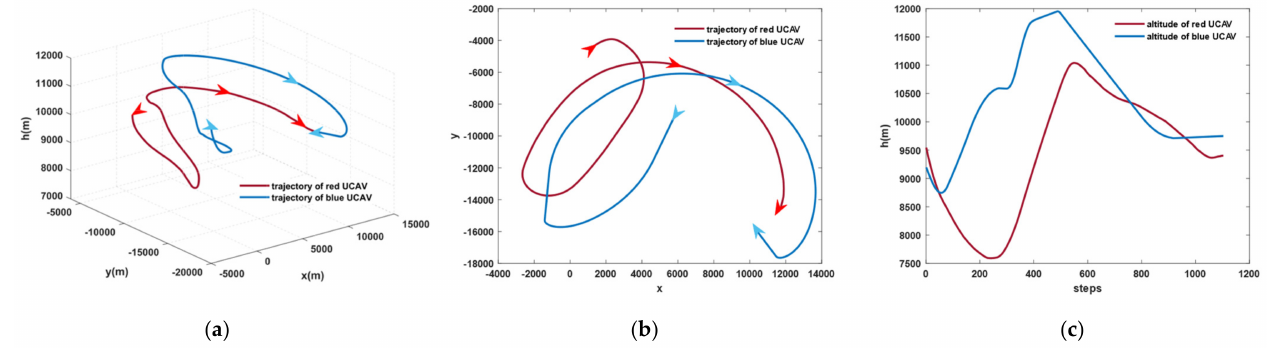
Figure 19. Trajectories for the air combat confrontation example: ( a ) two UCAVs; ( b ) top view of the two UCAVs; ( c ) altitudes of the two